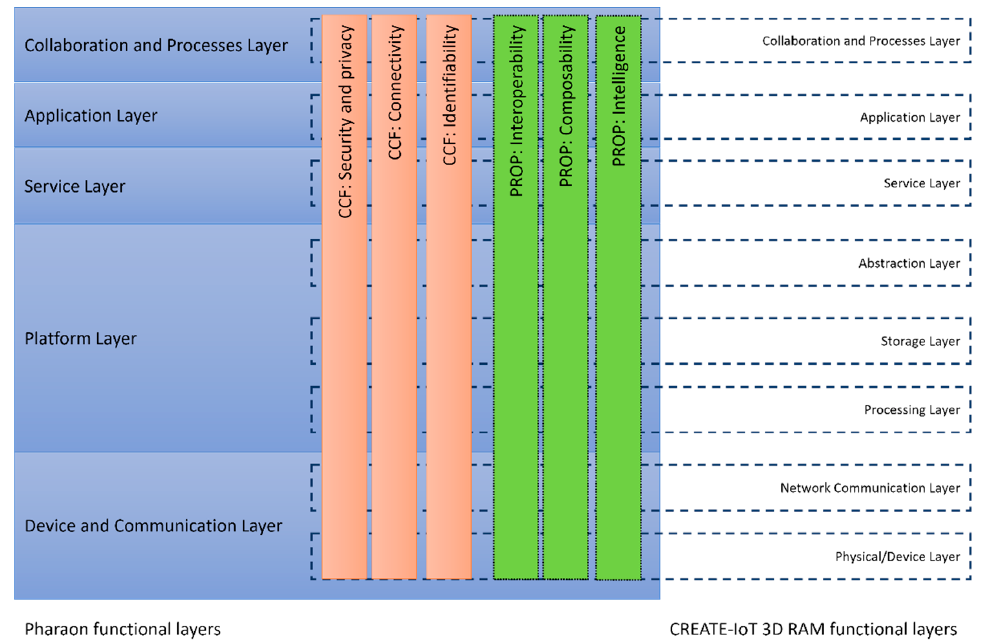
Figure 3. Pharaon reference logical architecture view mapped to CREATE-IoT 3D RAM.